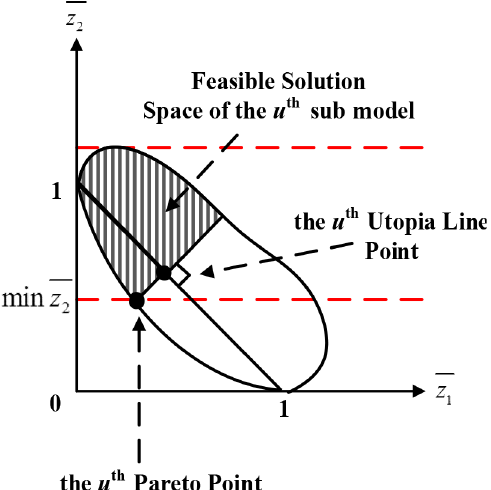
Figure 3. Diagram of the u th step calculation